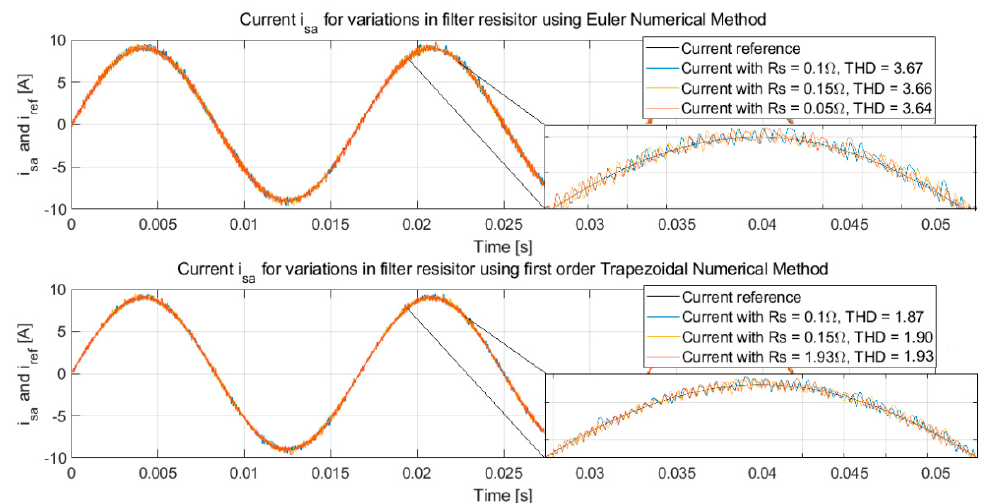
Figure 15. Current i sa for variations in the filter resistor using Euler and first-order trapezoidal approximations.